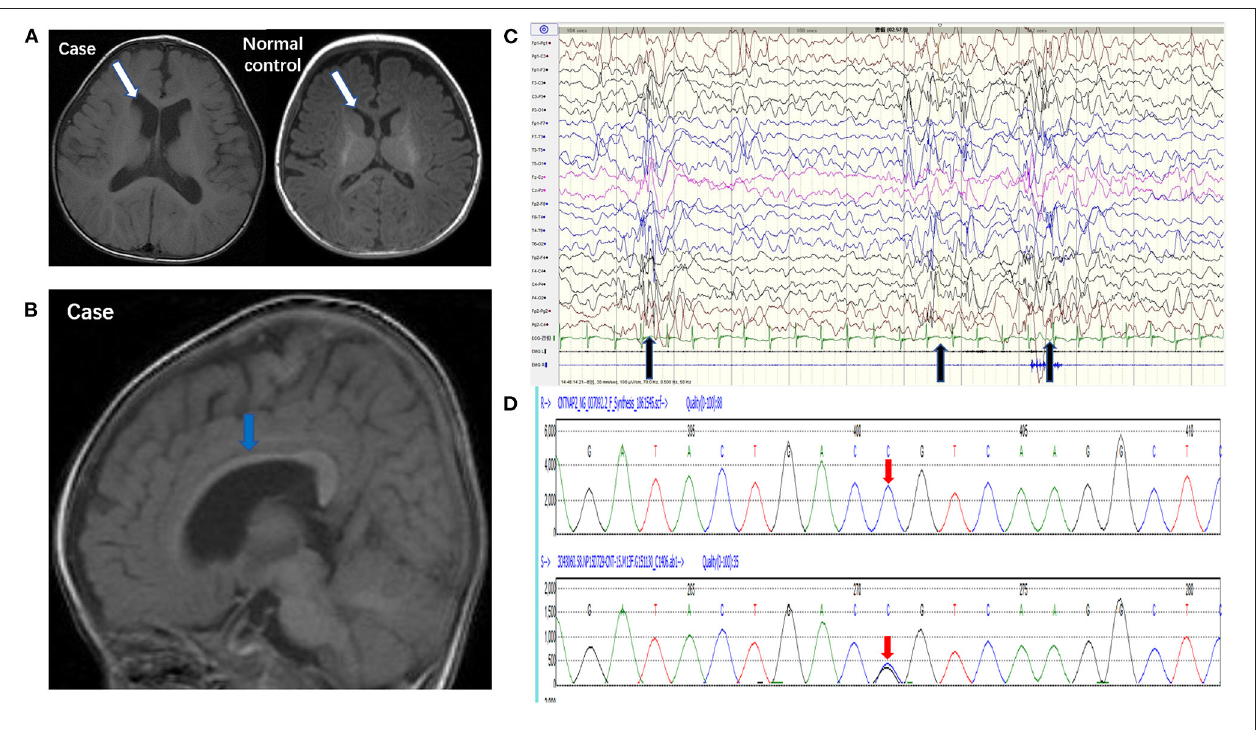
FIGURE 1 | Pedigrees of the case carrying a CNTNAP2 R777G mutation. (A) 3.0T MRI (axial T1) of the patient (left) and normal control (right) showed mild enlargement of ventricle (white arrow). (B) 3.0T MRI (sagittal T1) showed corpus callosum dysplasia (blue arrow). (C) EEG showed intermittent hypsarrhythmia and superimposed with epileptic discharges at bilateral parieto-occipital area (black arrow). (D) CNTNAP2 DNA from peripheral blood leucocytes of the patient was analyzed by Sanger sequencing (the upper red arrow indicates normal base sequence and the lower red arrow indicates the c.2329 C > G